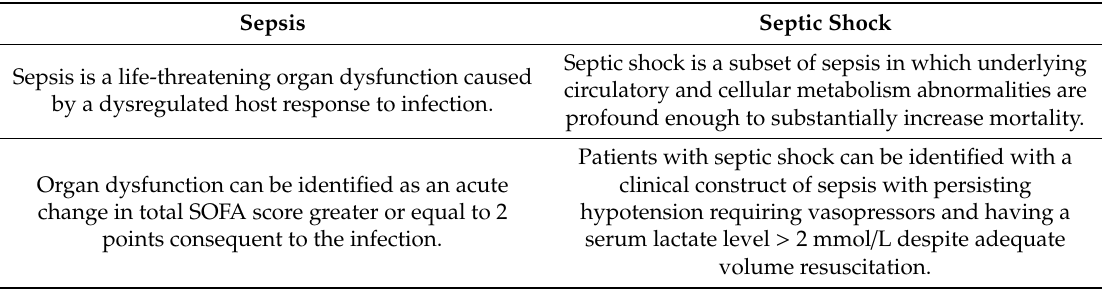
Table 3. “ Sepsis- 3” definitions and identifying features, adapted from Singer et al. [22]. Sepsis